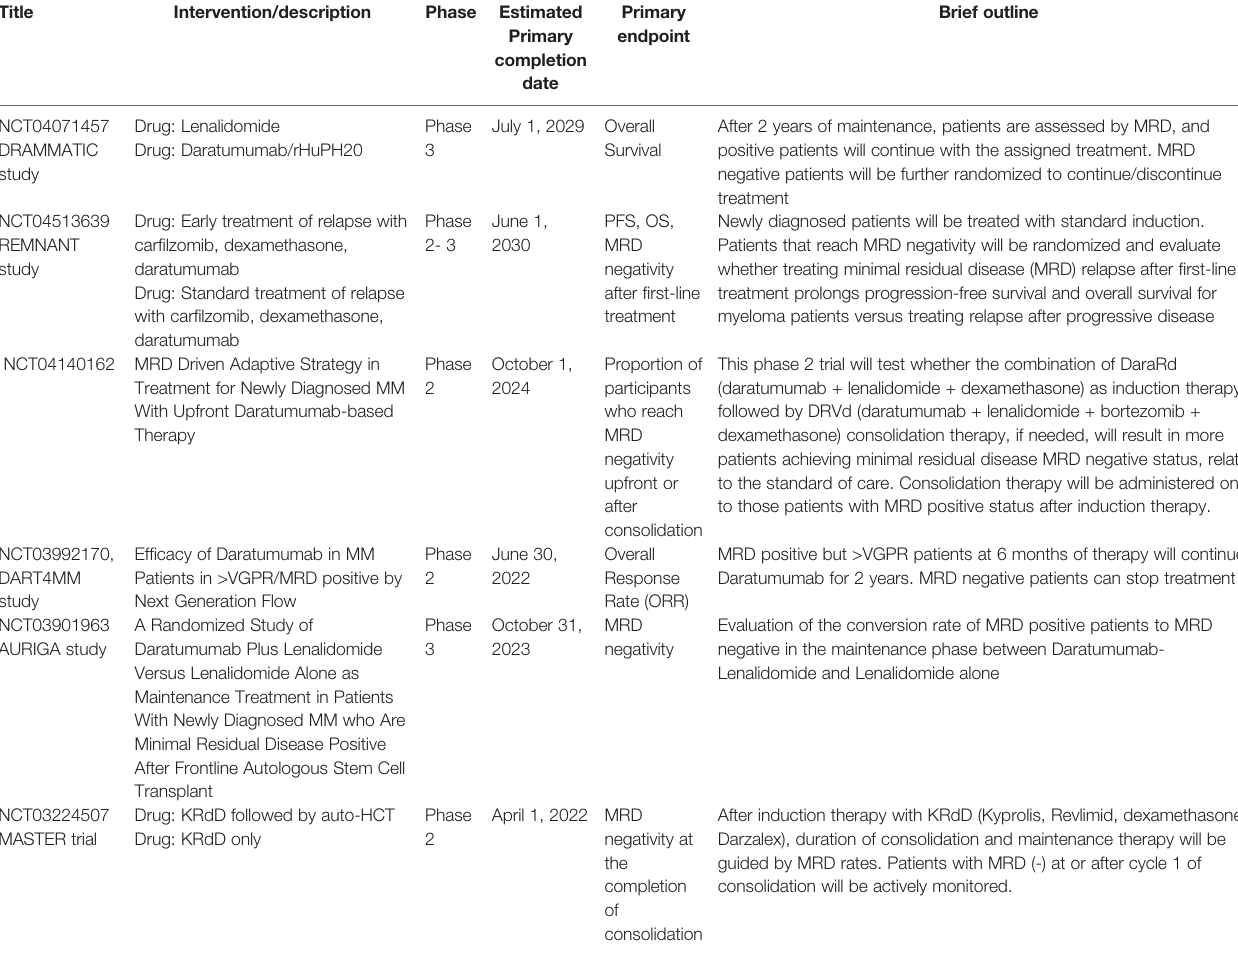
TABLE 3 | Selected trials with MRD status guiding intensi fi cation or de-intensi fi cation of